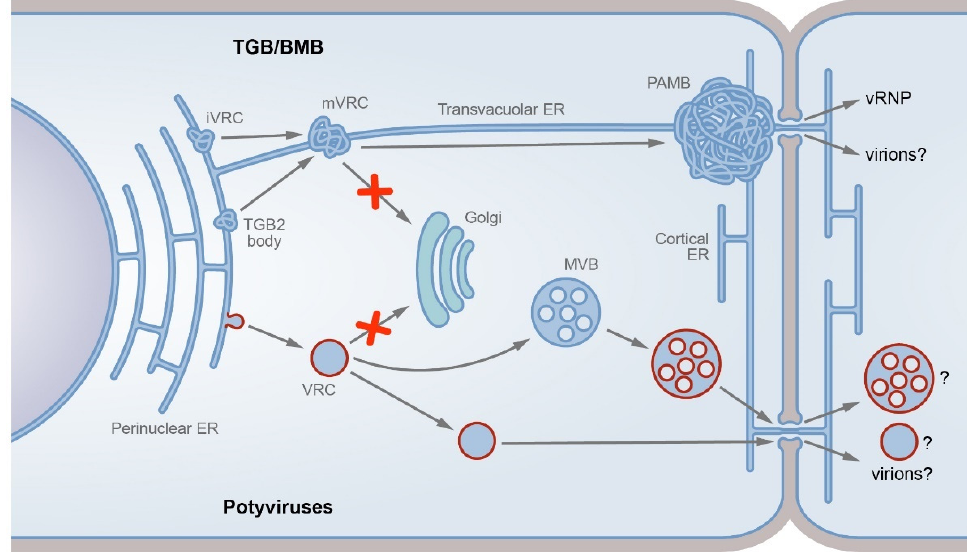
Figure 1. TGB/BMB-specific and potyvirus-specific transport pathways. The two dissimilar pathways described are either modification of the ER tubules (TGB/BMB; upper part) or formation of motile vesicles detached from the endoplasmic reticulum and targeted to endosomes (potyviruses, bottom). In the TGB/BMB-specific pathway, the viral replicase forms initial virus replication complexes (iVRCs) on the ER membrane, whereas TGB2 can interact with the ER to form membrane TGB2 bodies. Due to TGB2 interaction with viral replicase, TGB2 targets iVRCs to convert them into movement VRCs (mVRCs). The mVRCs are capable of intracellular transport and can be transported along the cytoskeleton to the PD entrance, bypassing the Golgi-dependent trafficking pathway (shown by red cross sign). At the PD entrance, mVRCs form PD-associated membrane bodies (PAMBs), which represent ER-derived PD-anchored sites where virus replication is coupled to cell-to-cell virus transport. Virus ribonucleoprotein complexes (vRNPs) containing genomic RNA and MPs are formed in PAMBs and directed to the PD channels. Alternatively, virions, likely MP-modified, can be the virus transport form (indicated by question mark). In the potyvirus-specific pathway, the viral 6K 2 protein induces the formation of VRCs on the ER membrane. The potyvirus VRCs, which carry viral proteins, virus RNA, and cellular factors, are detached from the ER membrane in a COPII-dependent manner. Further VRC intracellular trafficking bypasses the Golgi pathway (red cross sign). The VRCs target late endosomes (multivesicular bodies, MVBs), which in turn target PD. Alternatively, the VRCs can directly target PD. The potyvirus-specific entity transported through the PD channels is unknown and can be VRC, modified MVB, or virion (indicated by question marks).